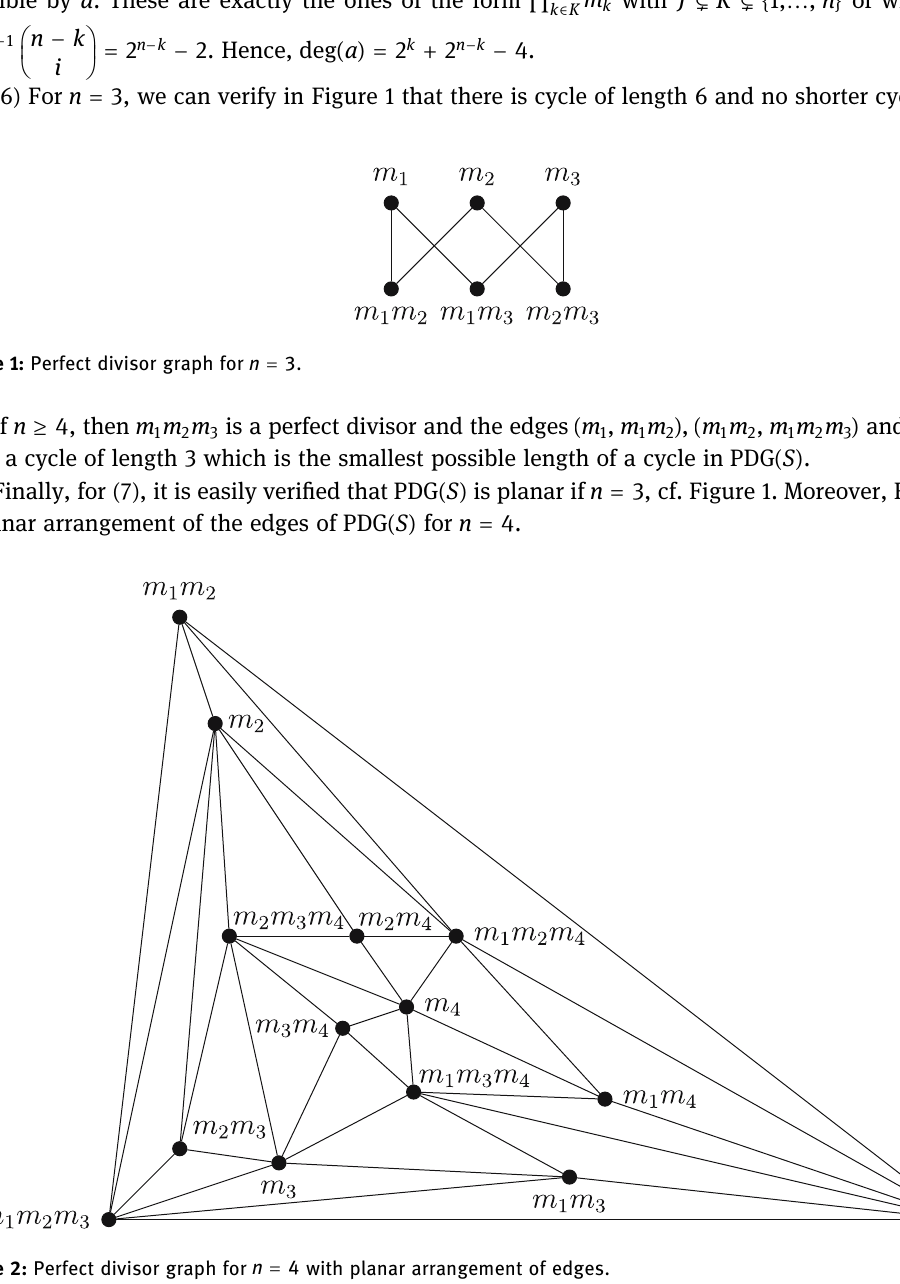
Figure 2: Perfect divisor graph for = n 4 with planar arrangement of edges.